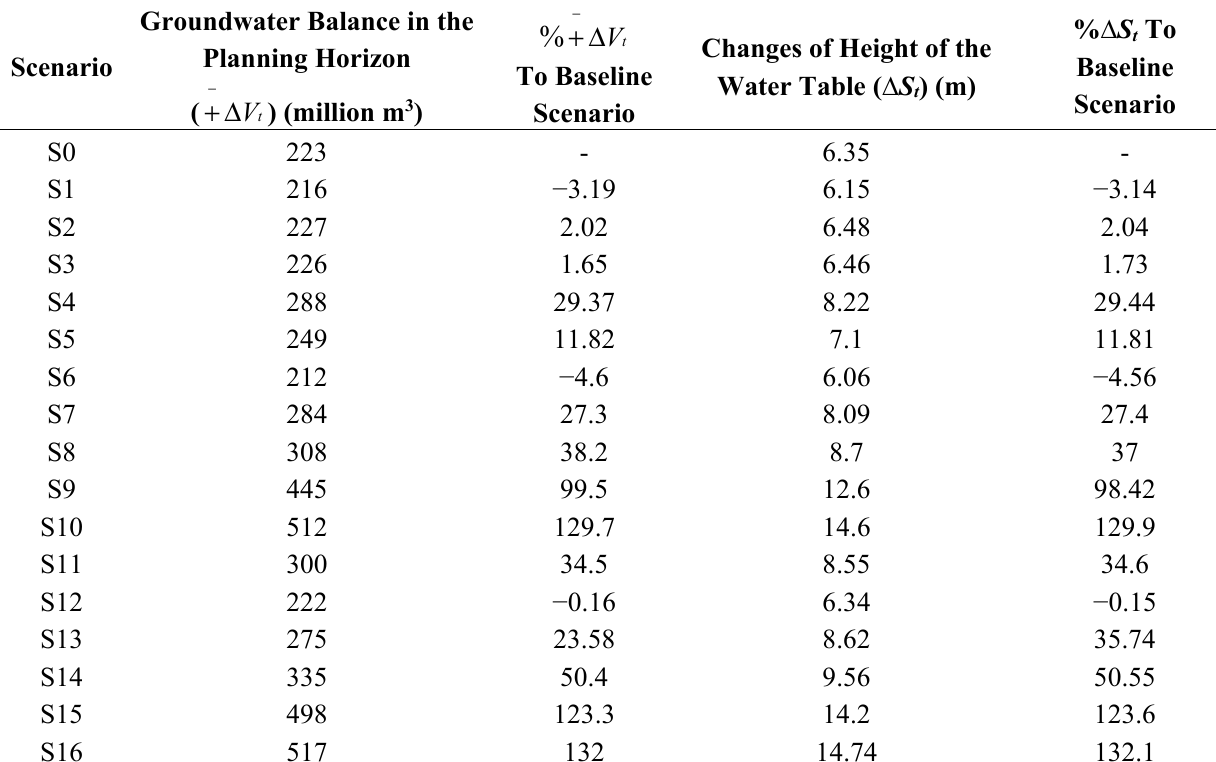
Table 4. Groundwater volume fluctuations under different economic scenarios in Wet climate condition on the planning horizon